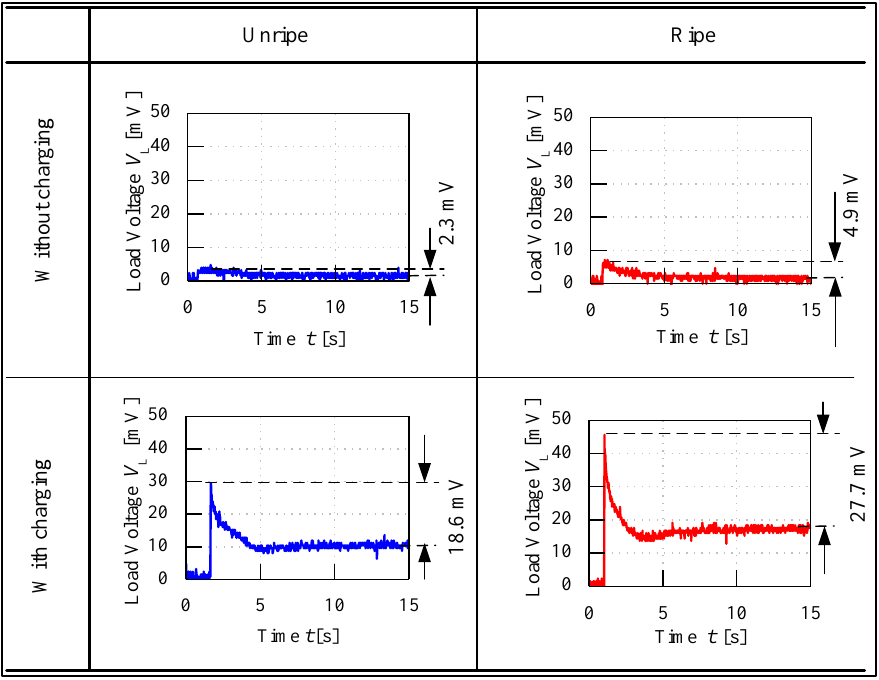
Figure 7. Load resistance voltage characteristics of fruit battery with and without charging process.